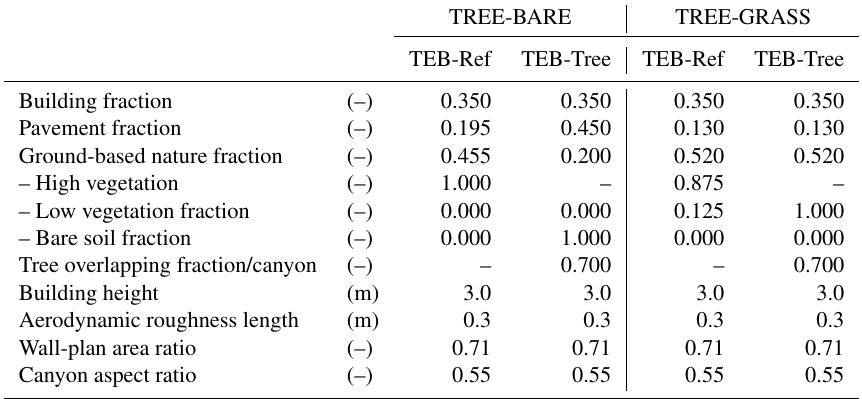
Table 1. TEB input parameters according to the two configurations prescribed to represent the experimental site of Sde-Boqer according to the TEB-Ref and TEB-Tree versions (in accordance with Fig.